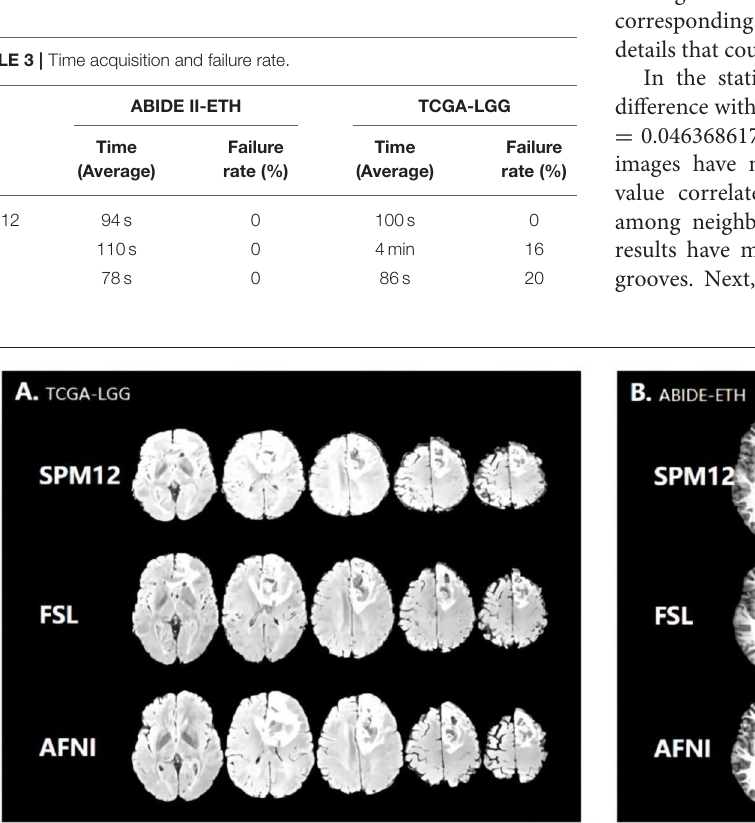
Frontiers in Public Health |